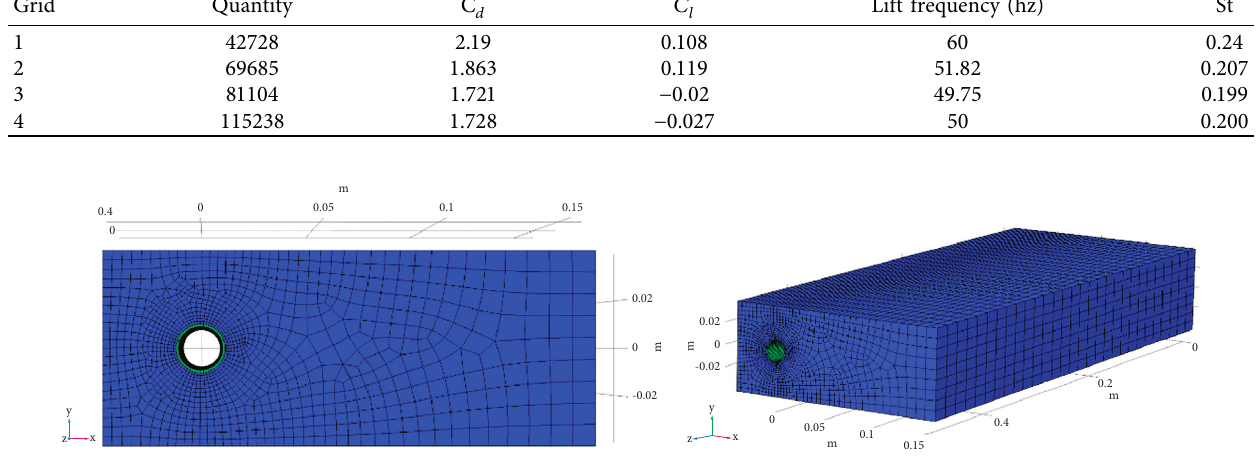
Figure 8: Schematic diagram of grid division.